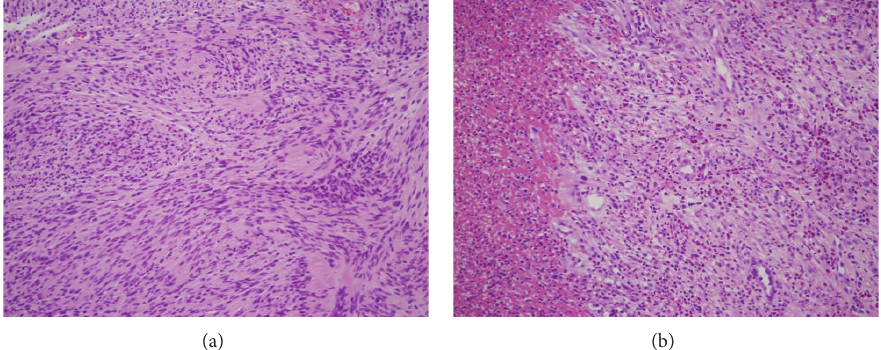
Figure6:Histopathologicalimage(firstbiopsy:a,b:H-E × 200).Eosinophilicspindlecellswitharound-likeorovalnucleuswereproliferating in the lamina propria. There were rough myxoma-like lesions and those with a high cell density palisading arrangement depending on the location, and abundant inner vascularity.